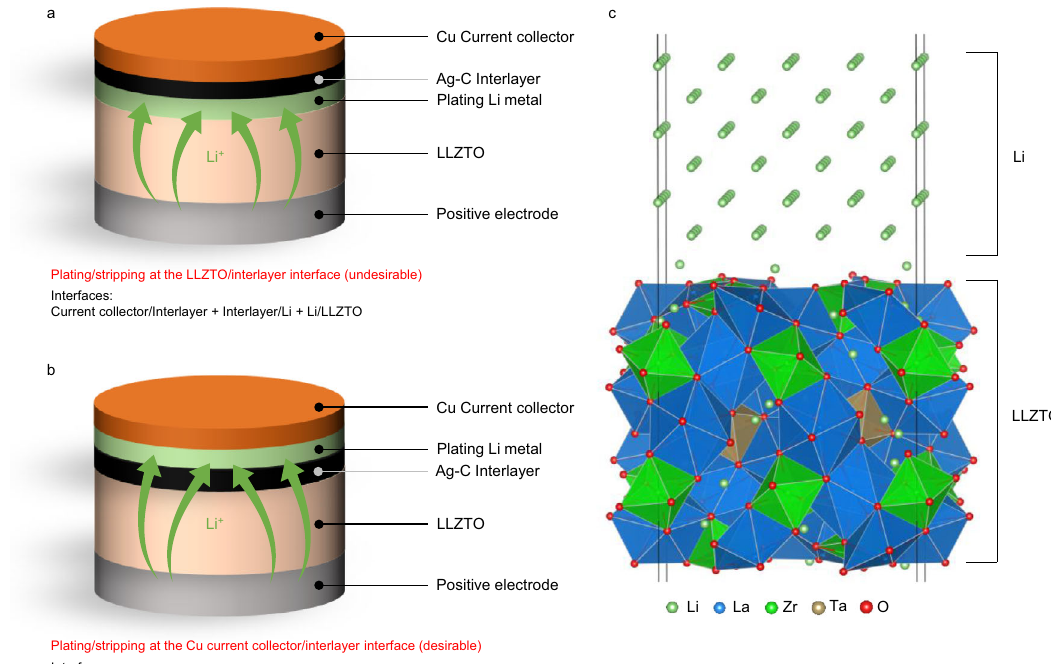
Fig. 1 | Two possible scenarios of Li deposition in LMBs with interlayer. a An undesirable case where Li plates/strips at the LLZTO/interlayer interface. b A